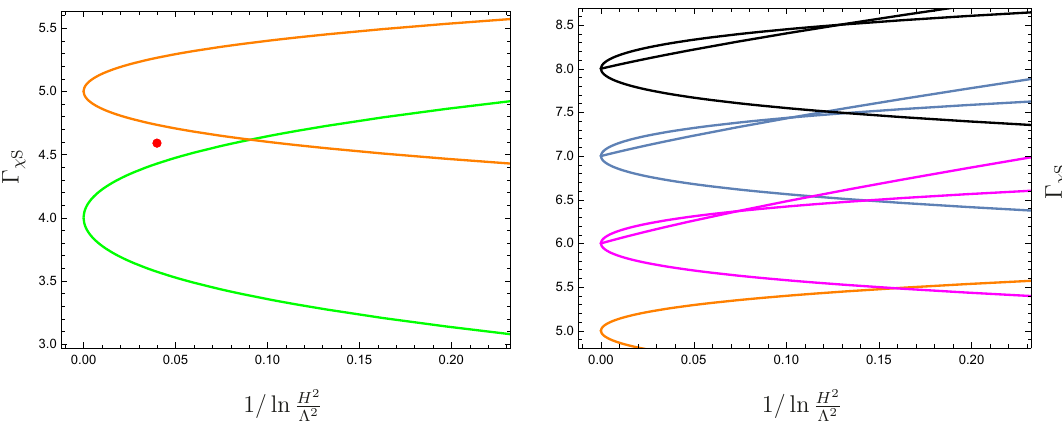
Figure 10 . Leading order correction to the conformal spectra for the chiral symmetry breaking fluctuations at higher n . Note that the (perturbative) coalescence of various sub-branches is quite generic. The red dot (the left panel) is a replot of the red dot from figure 9.